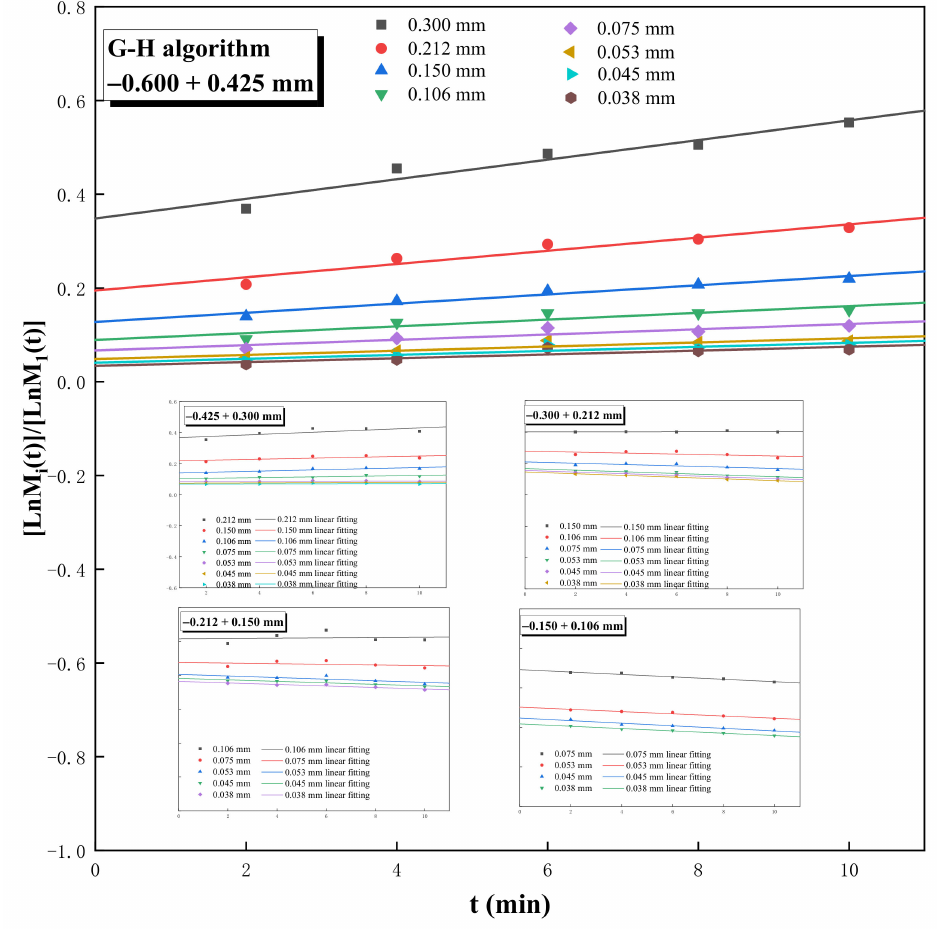
Figure 4. G–H algorithm plot for magnetite wet-grinding